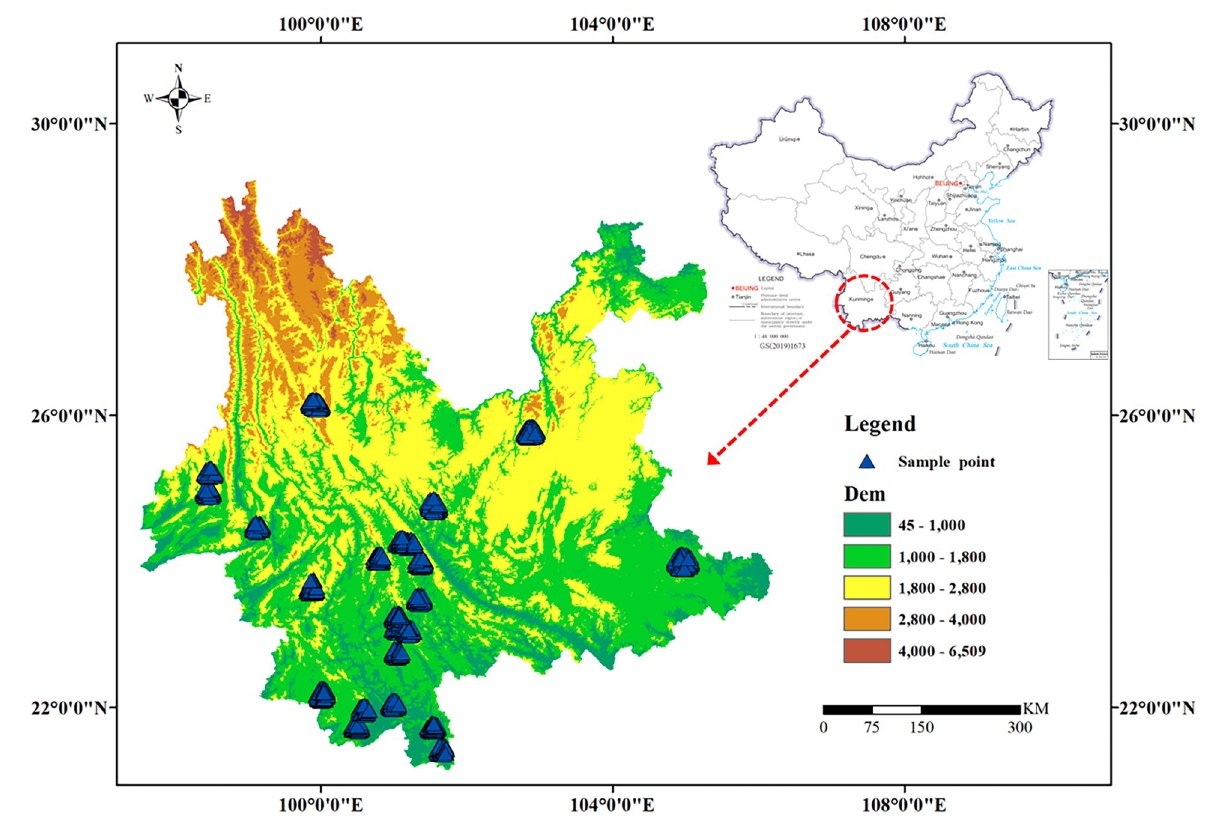
Fig 1. Digital Elevation Map (DEM) of Yunnan Province, China. Shape file source: republished from http://www.gscloud.cn under a CC BY license, with permission from Geospatial Data Cloud, original copyright [2022]; Own Map output: using ArcGIS 10.8 Software analysis.